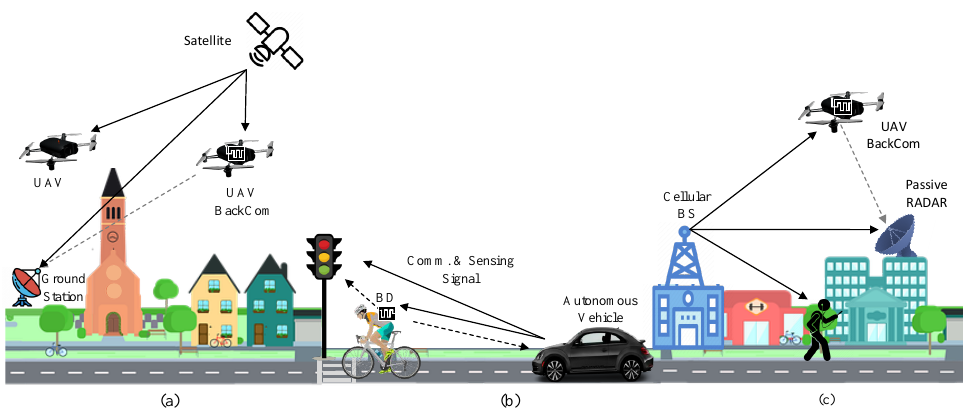
Figure 9. Symbiotic communication and sensing use cases; ( a ) non-terrestrial networks ( b ) vehicle-to- everything, ( c ) passive RADAR